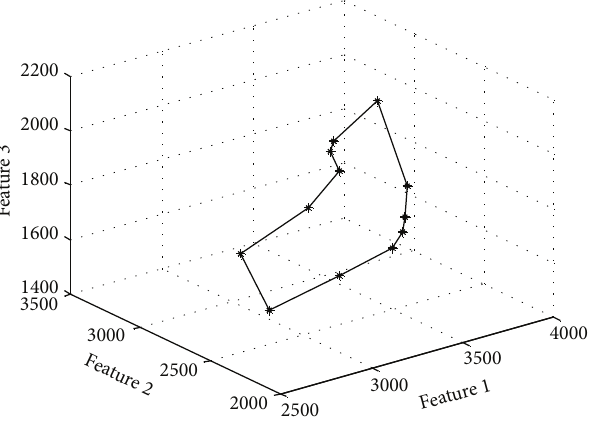
Figure 7: Compressed features by PCA.